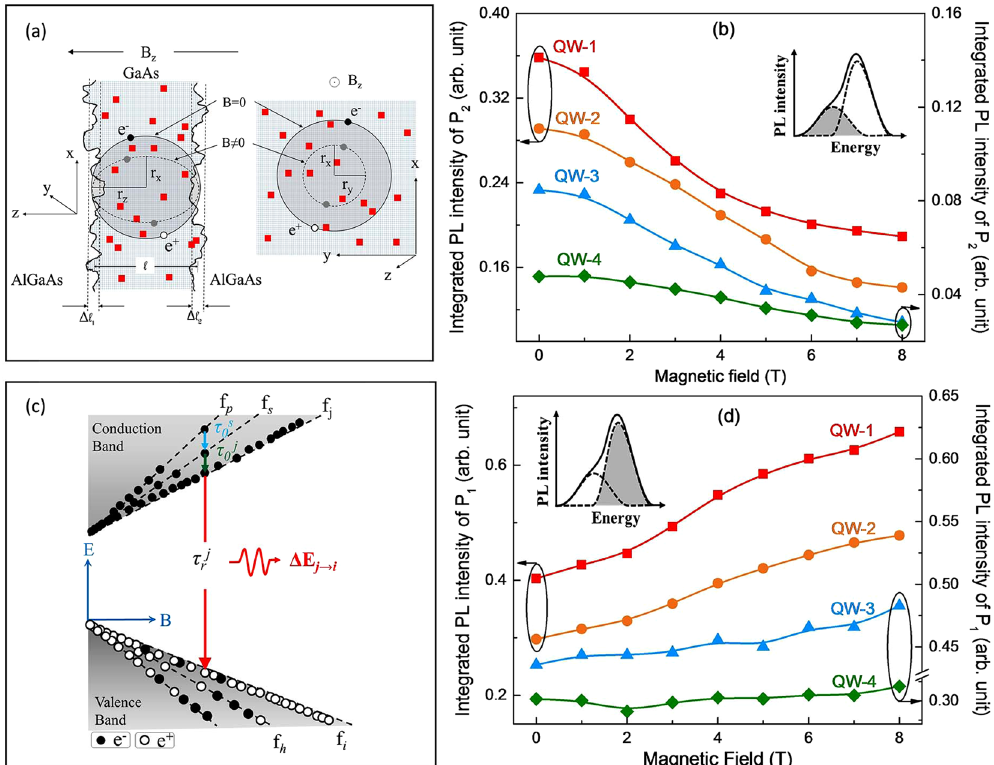
Figure 7. ( a ) Spatial extent of exciton inside the QW is shown. Red dots in the figure represent random defects, disorder, and impurity ( δ 2 ) in GaAs layer. In presence of magnetic field, spatial extent of exciton reduces and hence experience less volume-defects ( δ 2 ). However, experience of hetero-interface potential fluctuation ( δ 1 ) remains nearly invariant. ( b ) Figure shows the trend of decrease in P 2 with magnetic field follows the similar trend as magnetic field driven confinement of exciton. ( c ) Shows the excitonic radiative recombination between j th state of conduction band and i th state of valence band (lifetime τ rj ). Increase in magnetic field results in splitting of energy levels (i.e. Landau levels). Carrier density ( n j ) in each Landau level may significantly change with increase in magnetic field. The symbol τ k signifies average relaxation lifetime of charge carriers to the 0 energy level k . ( d ) Integrated intensity of Gaussian function peak P 1 , originated from free exciton radiative recombination, increases with magnetic field. Data is normalized by the excitation power density received by the respective QW in MQW